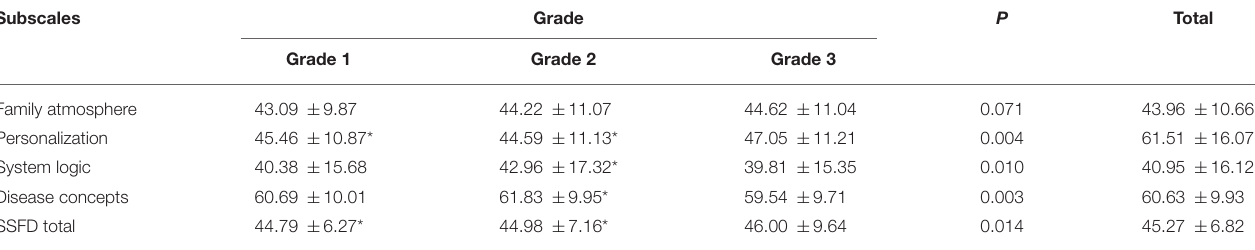
TABLE 3 | Comparison of standardized scores of each subscale of SSDF among different grades ( x ± s ).